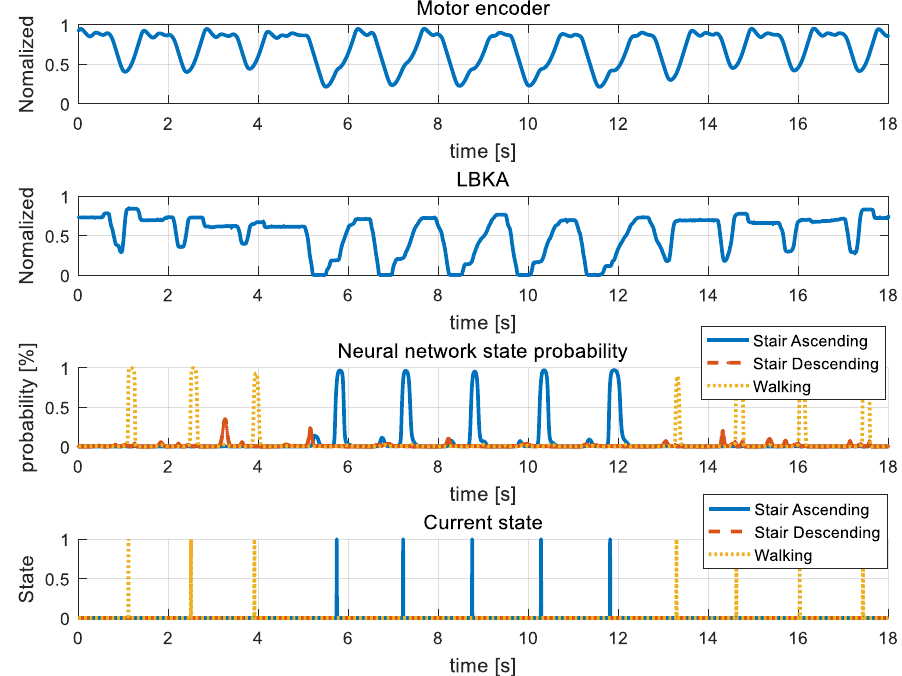
Figure 15. Mixed stair ascending experiment. In the graph, sensor data and neural network result in walking → stair ascending → walking mixed state are plotted. Also, the current state determined by state decision algorithm is plotted.